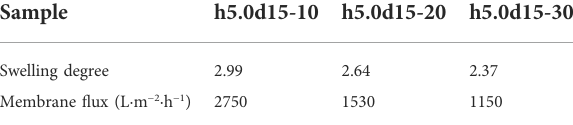
TABLE 2 Swelling degree and Membrane fl ux of